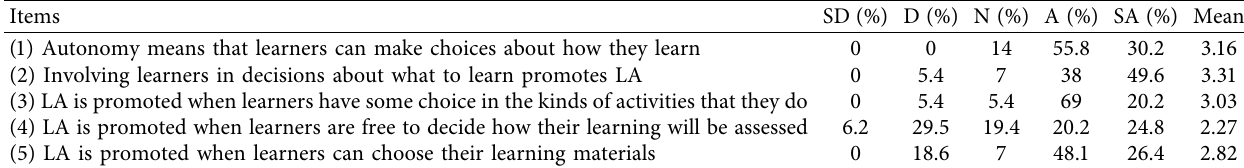
Table 6: Descriptive statistics of the political orientation of autonomy.